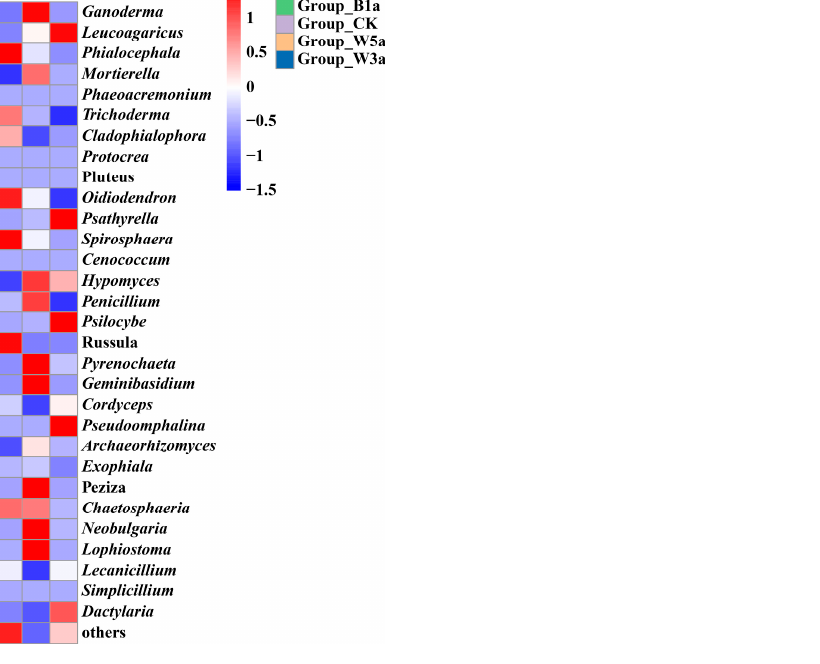
Figure 4. The composition of fungal communities at the genus level in the casing soil of different treatments of G. leucocontextum cultivation .